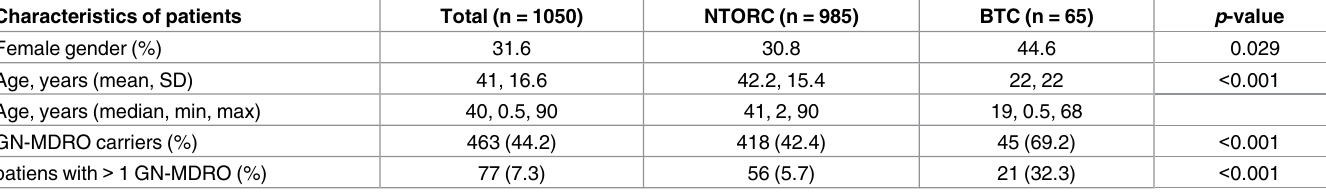
Table 2. Patient characteristics of the study population with univariable analysis of the two study sites. Characteristics of